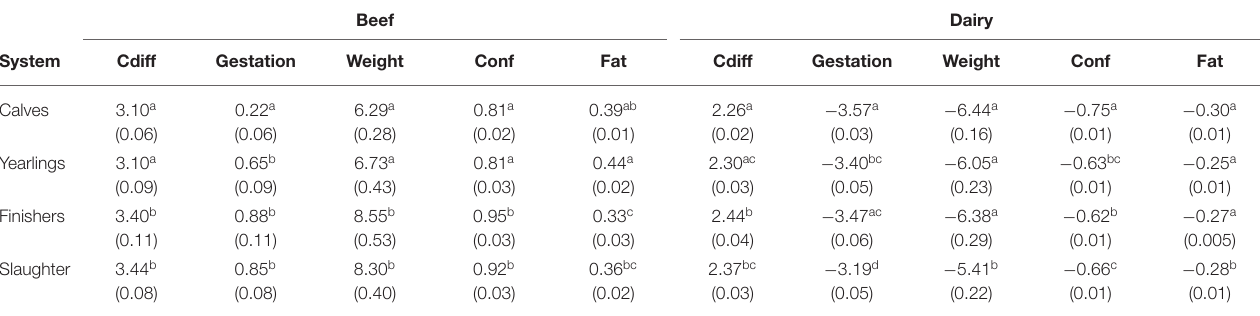
abc Differences in letters within columns signify a difference (p < 0.05) in least squares means.